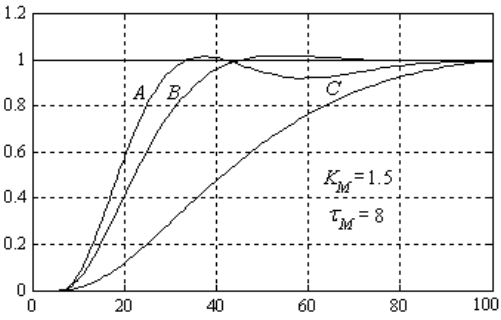
Figure 17. Responses y ( t ) to a unit step reference for: (A) T sM = 88, K = 3.7; (B) T sM = 73, K = 2.4; (C) T sM = 58, K = 0.45.